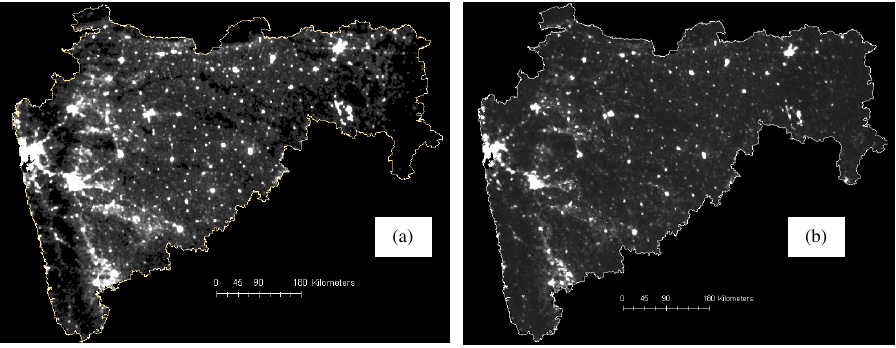
Figure 1: The state of Maharashtra as obtained from two DMSP-OLS images of 2001. (a) Maharashtra shown using the stable lights dataset. (b) Maharashtra shown using the radiance calibrated dataset (showing brightness values) percentage of households with cars, jeeps and vans; percentage of households with television; percentage of permanent census houses and percentage of households using electricity as power source. Maps are produced for the villages in the districts of Pune in the state of Maharashtra. The use of multi-scale data led to the consideration of issues arising from MAUP and ecological fallacy which are also described in this